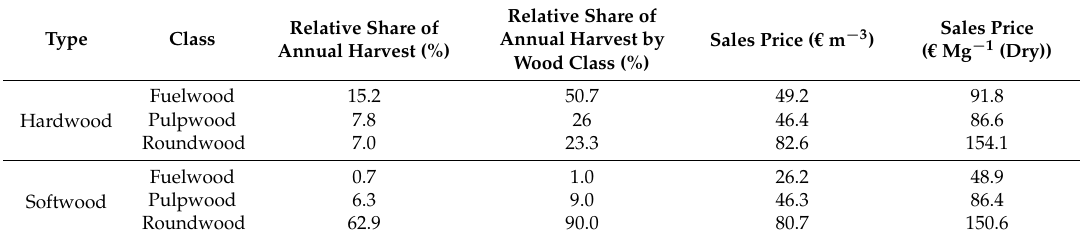
Table 5. Selling price and share of wood from forests (average 2011–2016) by type and assortment.